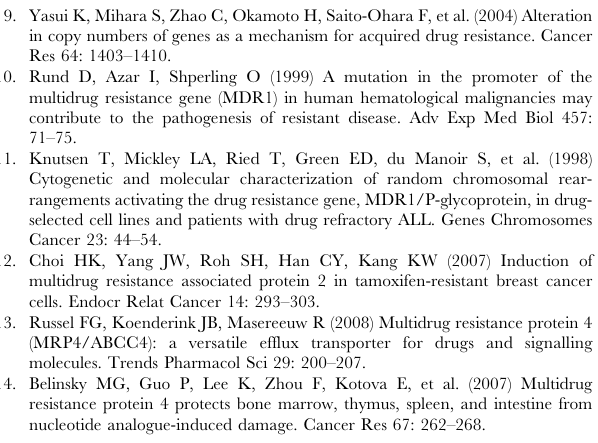
Figure S1 mFISH karyotype of wild-type J774 macro- phages. Chromosomes are displayed with false colors, as indicated by rounds; squares indicate the combination of true colors given by the probes.